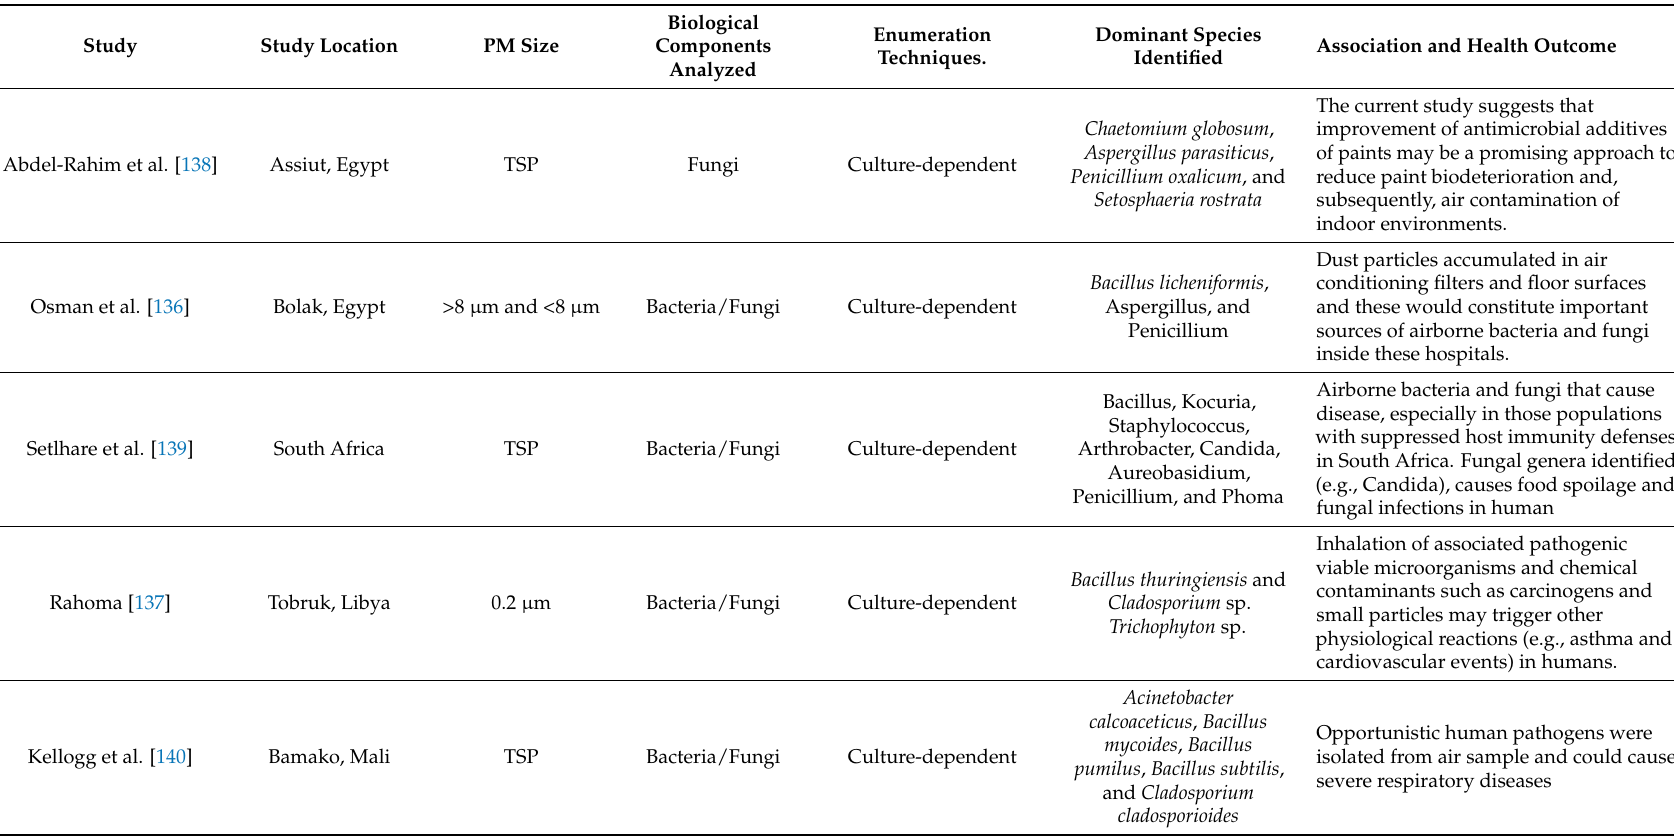
Table 3. Summary of the available information on the types of study, biological pollutants analyzed (either singly or in combination with PM), study population and location, observed health effects, and the details of cited